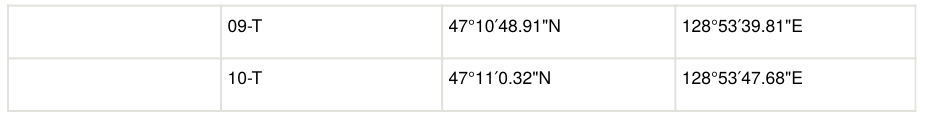
Reserve.Seed plant diversity of di ff erent forest types in Liangshui National Natural